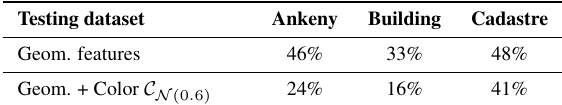
Table 6. Overall classification errors for inter-dataset experiments with LGBM classifier run with 2 sets of features: geometric only and both geometric and color. Color information yields a signifi- cant performance boost in prediction accuracy in all